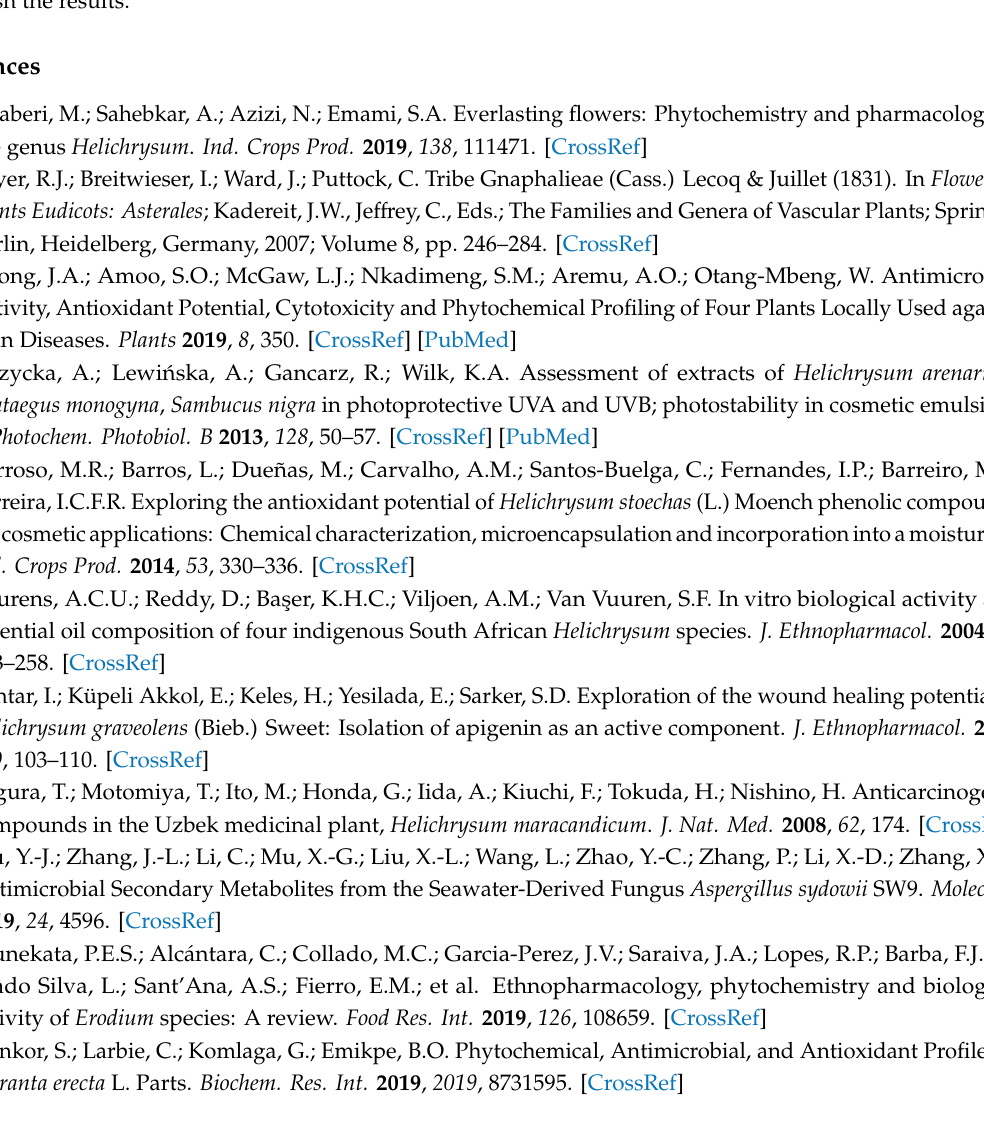
Figure S1: The total ion and HPLC-DAD chromatograms of Helichrysum plicatum ethanol extract (EE), Figure S2: The total ion and HPLC-DAD chromatograms of Helichrysum plicatum dichloromethane extract (DCME), Figure S3: The total ion and HPLC-DAD chromatograms of Helichrysum plicatum acetonitrile oil extract (ACNE), Table S1: Tentative analysis of Helichrysum plicatum ethanol extract (EE), Table S2: Tentative analysis of Helichrysum plicatum dichloromethane extract (DCME), Table S3: Tentative analysis of Helichrysum plicatum acetonitrile oil extract